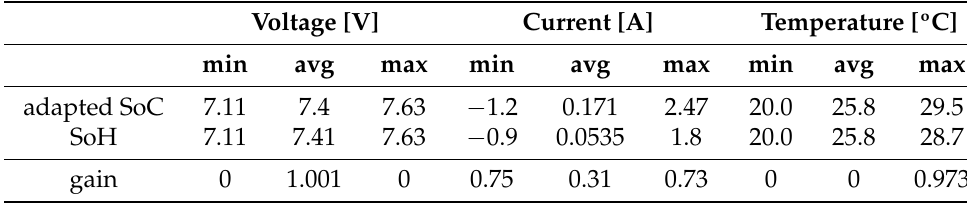
Table 6. Battery 1 during a month of simulation: Case 1.